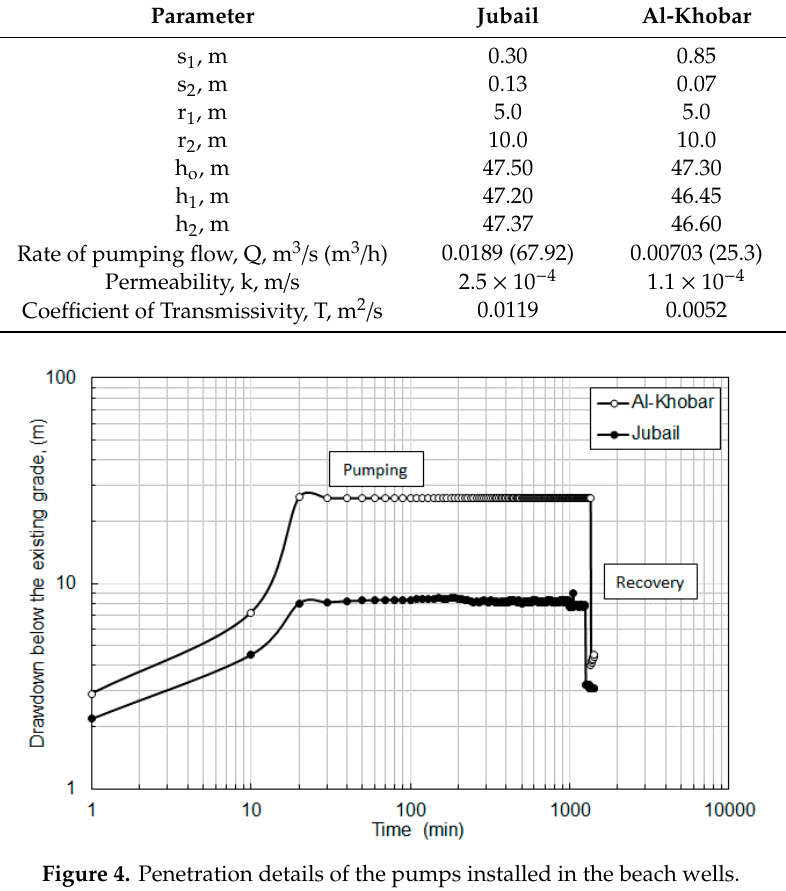
Figure 4. Penetration details of the pumps installed in the beach wells.